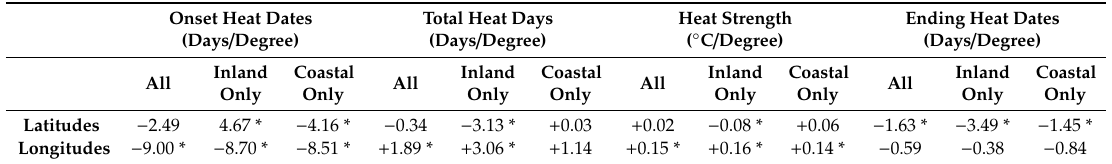
Table 1. The regression coe ffi cients of onset heat dates, total heat days, heat strength, and ending heat dates with the latitudes and the longitudes in cases of all, inland only, and coastal only stations. Onset Heat Dates Total Heat Days Heat Strength Ending Heat Dates (Days / Degree) (Days / Degree) ( ◦ C / Degree) (Days / Degree) Inland Coastal Inland Coastal Inland Coastal Inland Coastal All All All All Only Only Only Only Only Only Only Only Latitudes − 2.49 4.67